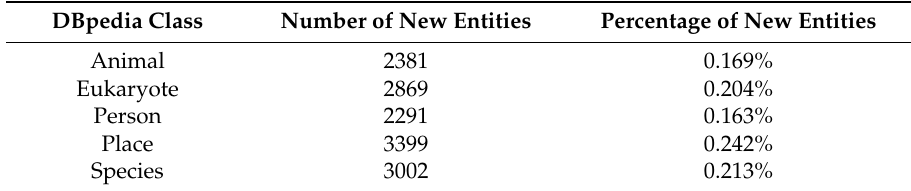
Table 19. DBpedia new entities based on the whole DBpedia knowledge